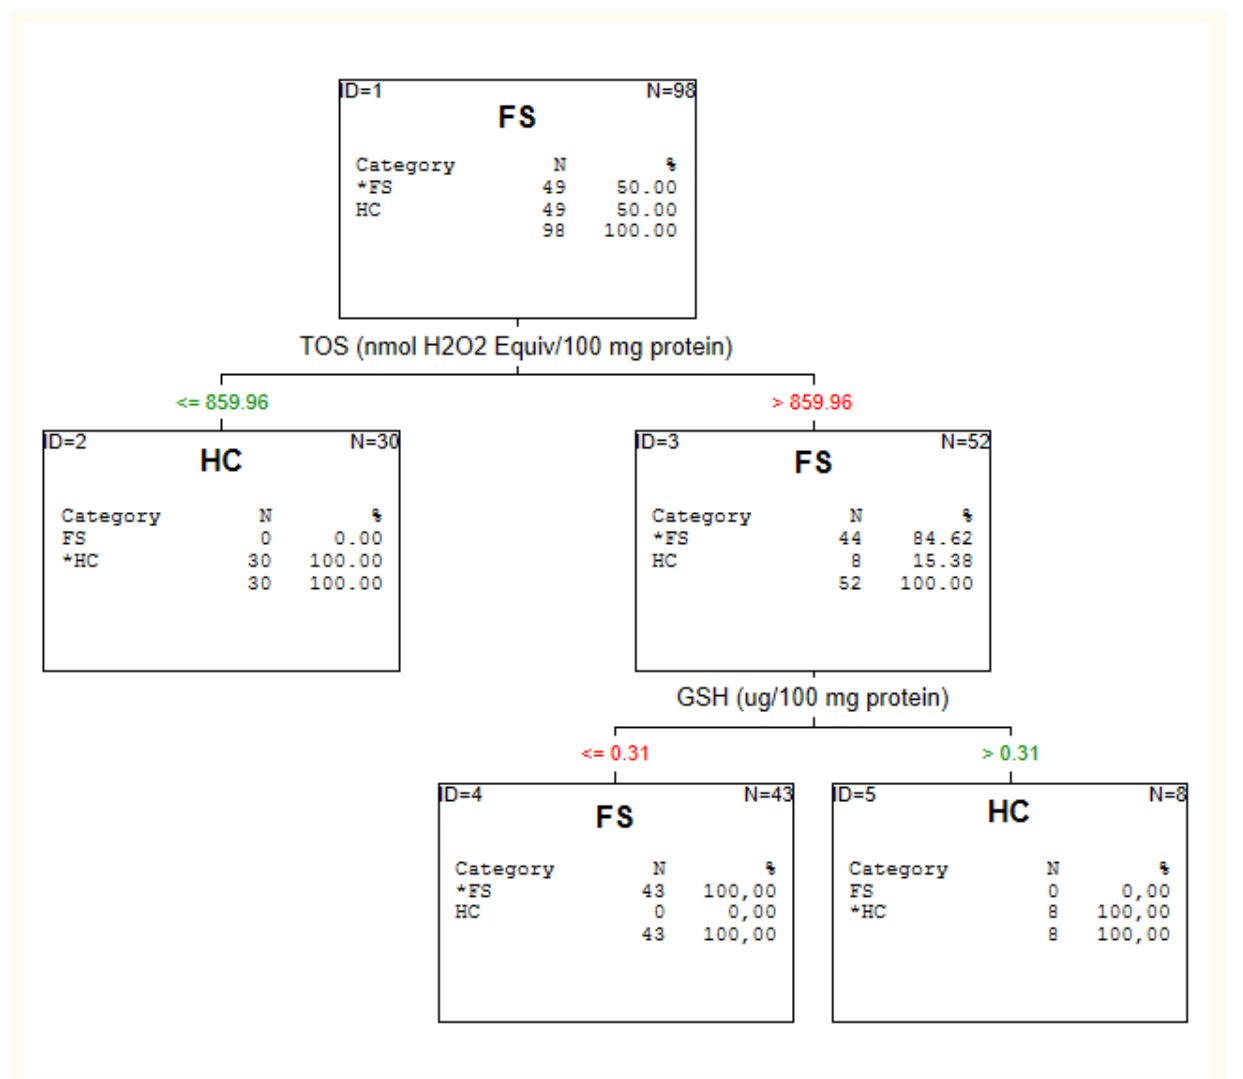
Figure 3. C&RT analysis for healthy individuals (HC) and first-episode patients (FS).